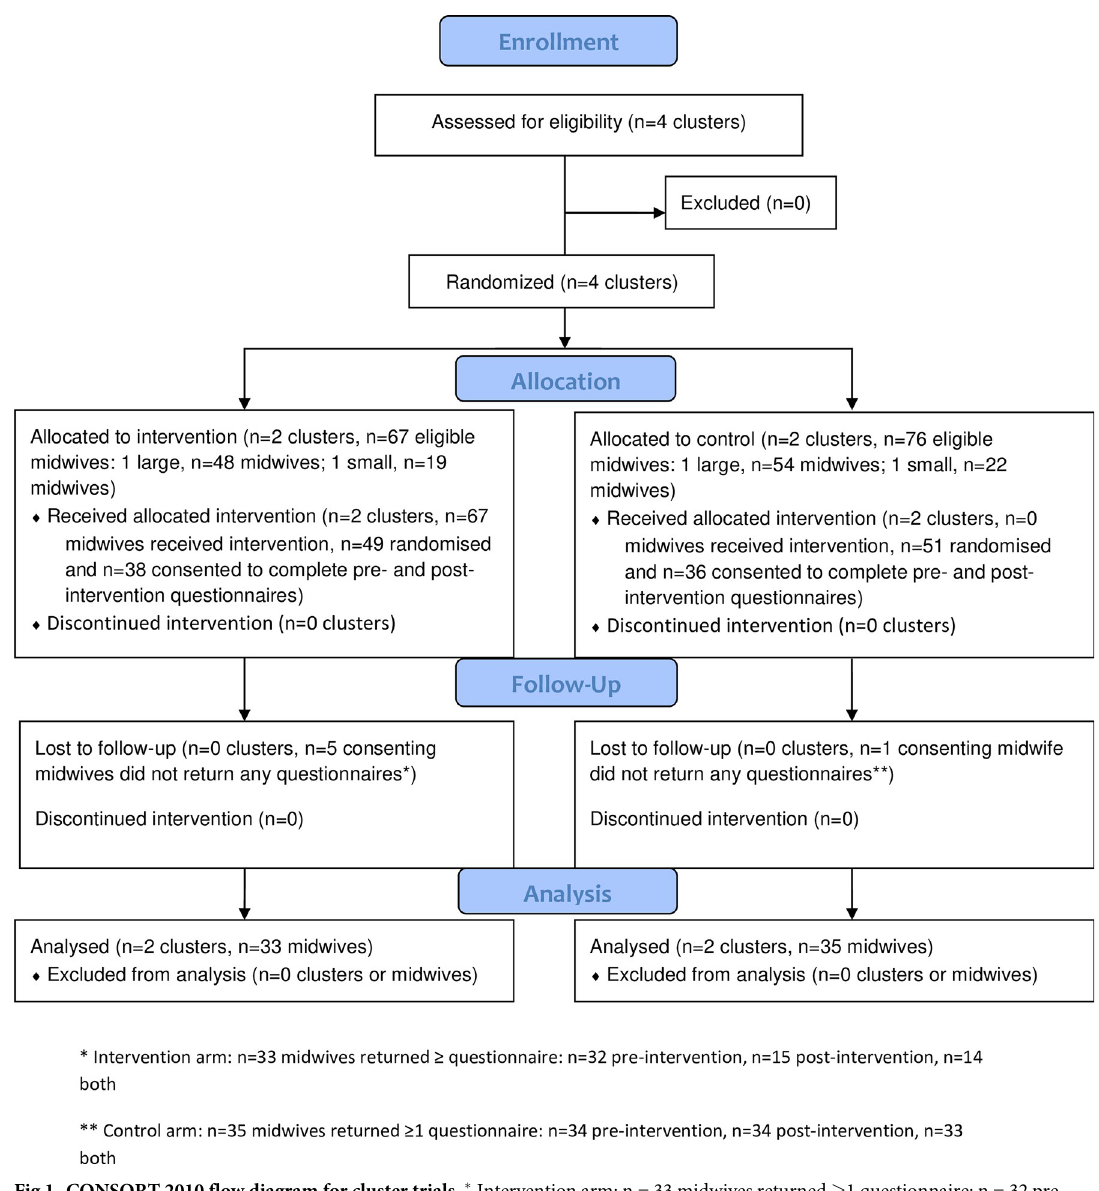
Fig 1. CONSORT 2010 flow diagram for cluster trials. � Intervention arm: n = 33 midwives returned � 1 questionnaire: n = 32 pre- intervention, n = 15 post-intervention, n = 14 both �� Control arm: n = 35 midwives returned � 1 questionnaire: n = 34 pre- intervention, n = 34 post-intervention, n = 33